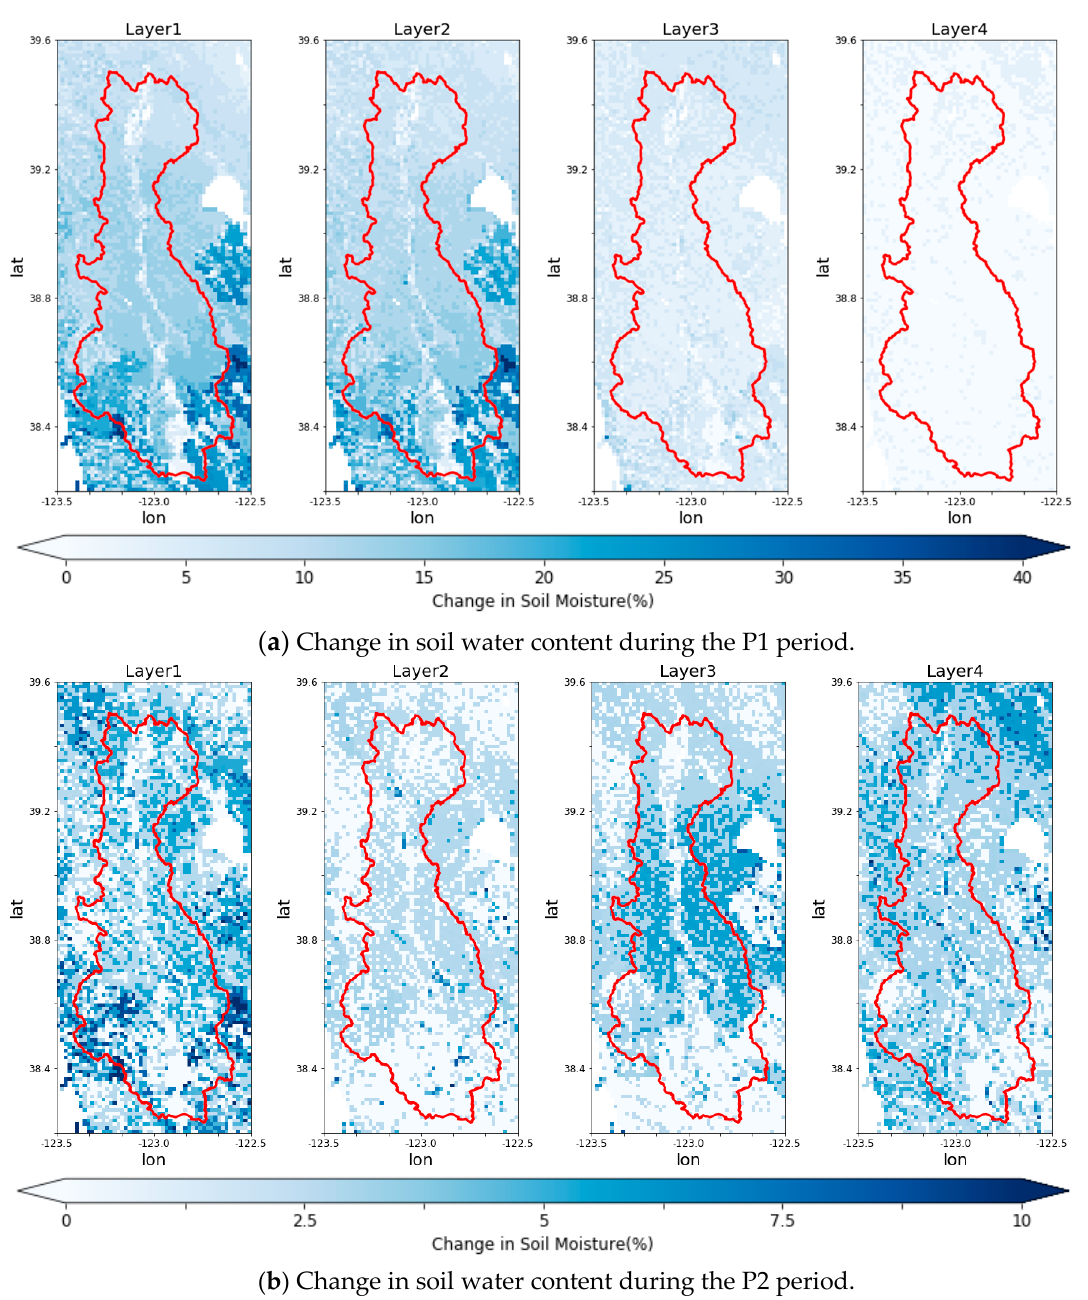
Figure 8. Changes in soil water content for each grid cell as the difference between the initial and peak time of the streamflow during ( a ) P1 and ( b ) P2. The ranges of change in soil moisture were 0–40% for P1 and 0–10% for P2.